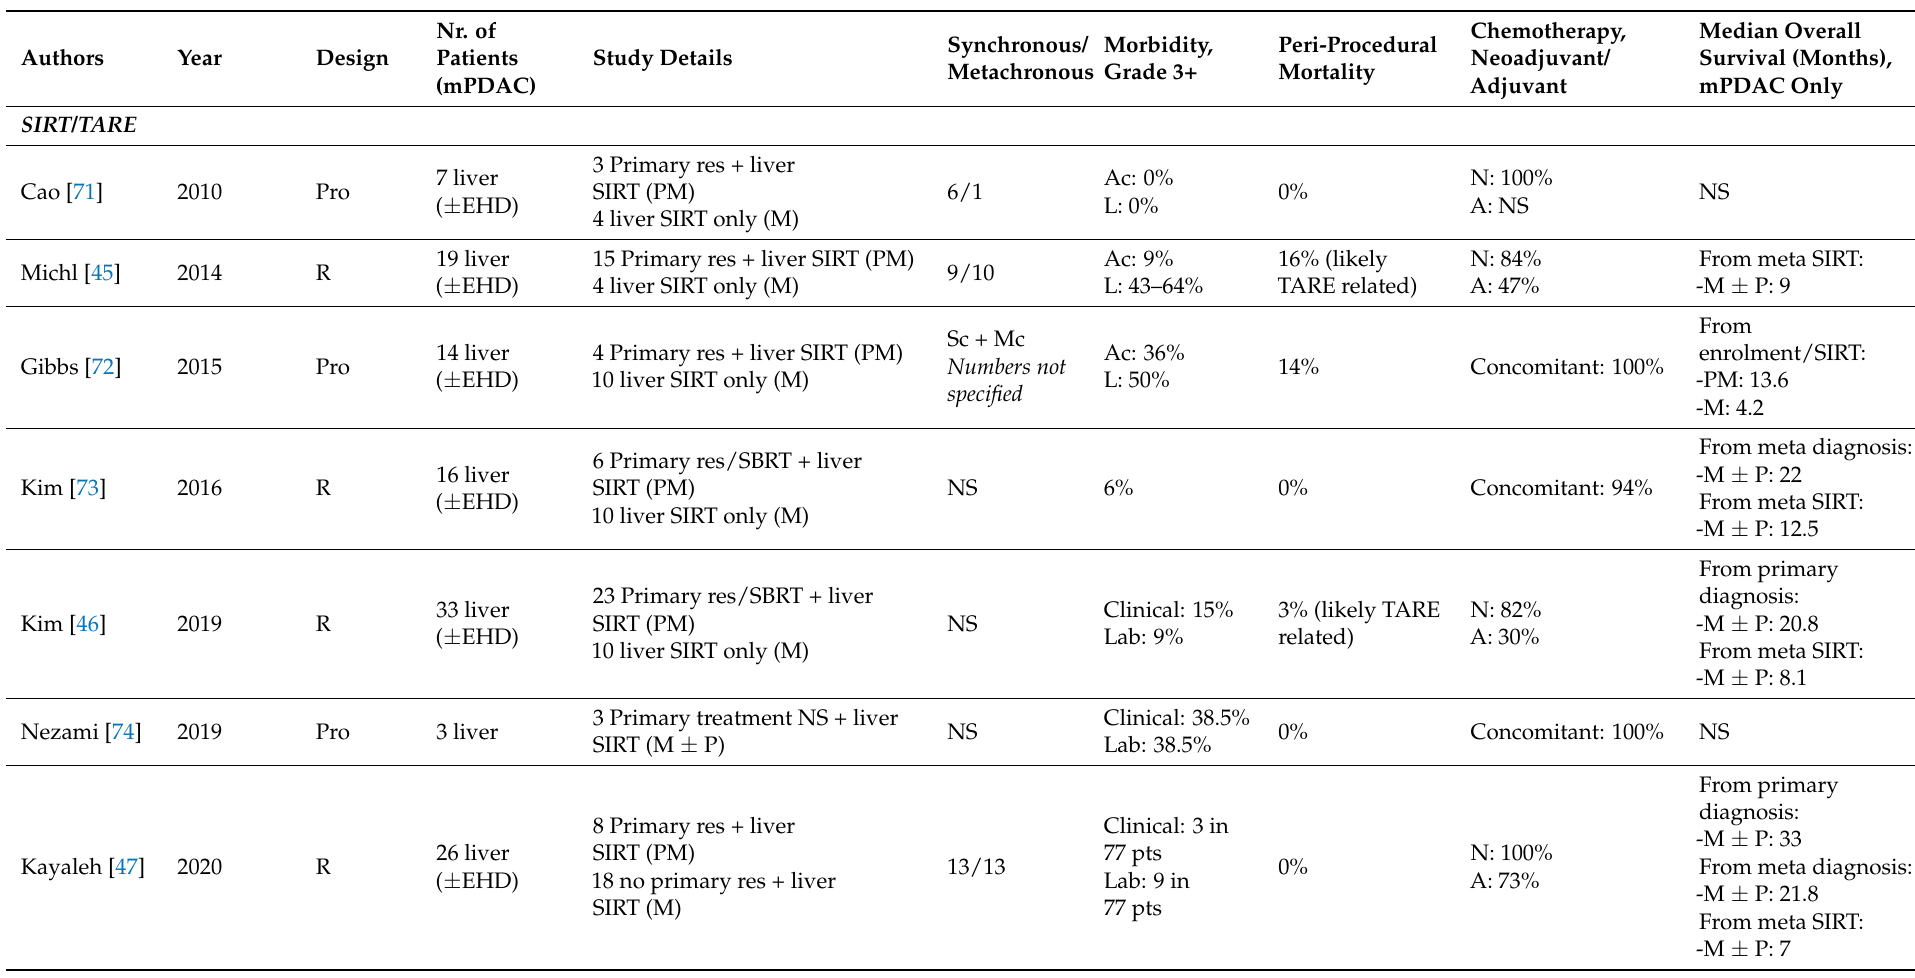
Table 6. Embolization in mPDAC. NS = not specified; R = retrospective; Pro = prospective; TARE = transarterial radioembolization; SIRT = selective internal radiation therapy (same as TARE); TACE = transarterial chemoembolization; PM = primary + metastatic locoregional treatment; P = primary locoregional treatment; M = metastatic locoregional treatment; res = resection; RFA = radiofrequency ablation; ISI = iodine-125 seed implantation; LDT = liver-directed therapy; N = neoadjuvant; A = adjuvant; EHD = extrahepatic disease; Sc = synchronous; Mc =